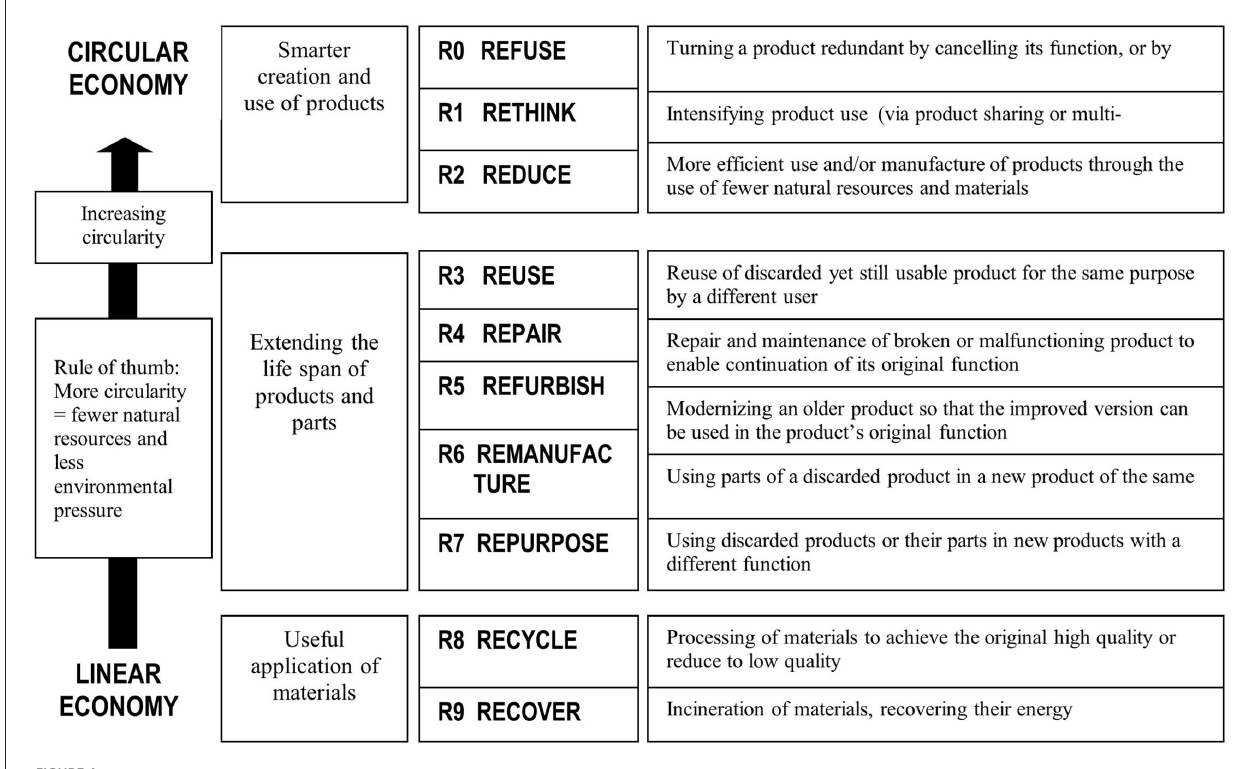
FIGURE4 The R’s of the circular economy. Source: Adapted from Potting et al. (2018).